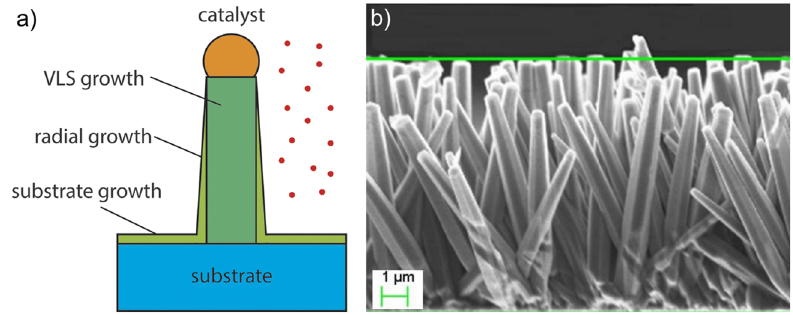
Figure 8: ( a ) Possible deposition pathways in a VLS system [ 90 ] . Depending on the growth parameters, VLS growth via catalyst alloy, radial overcoating on the existing NW sidewalls and thin fi lm deposition on the substrate may occur. ( b ) SEM image showing the morphology of as - grown ZnO nanorods arrays grown on the silicon substrate ( side view ) [ 54 ]